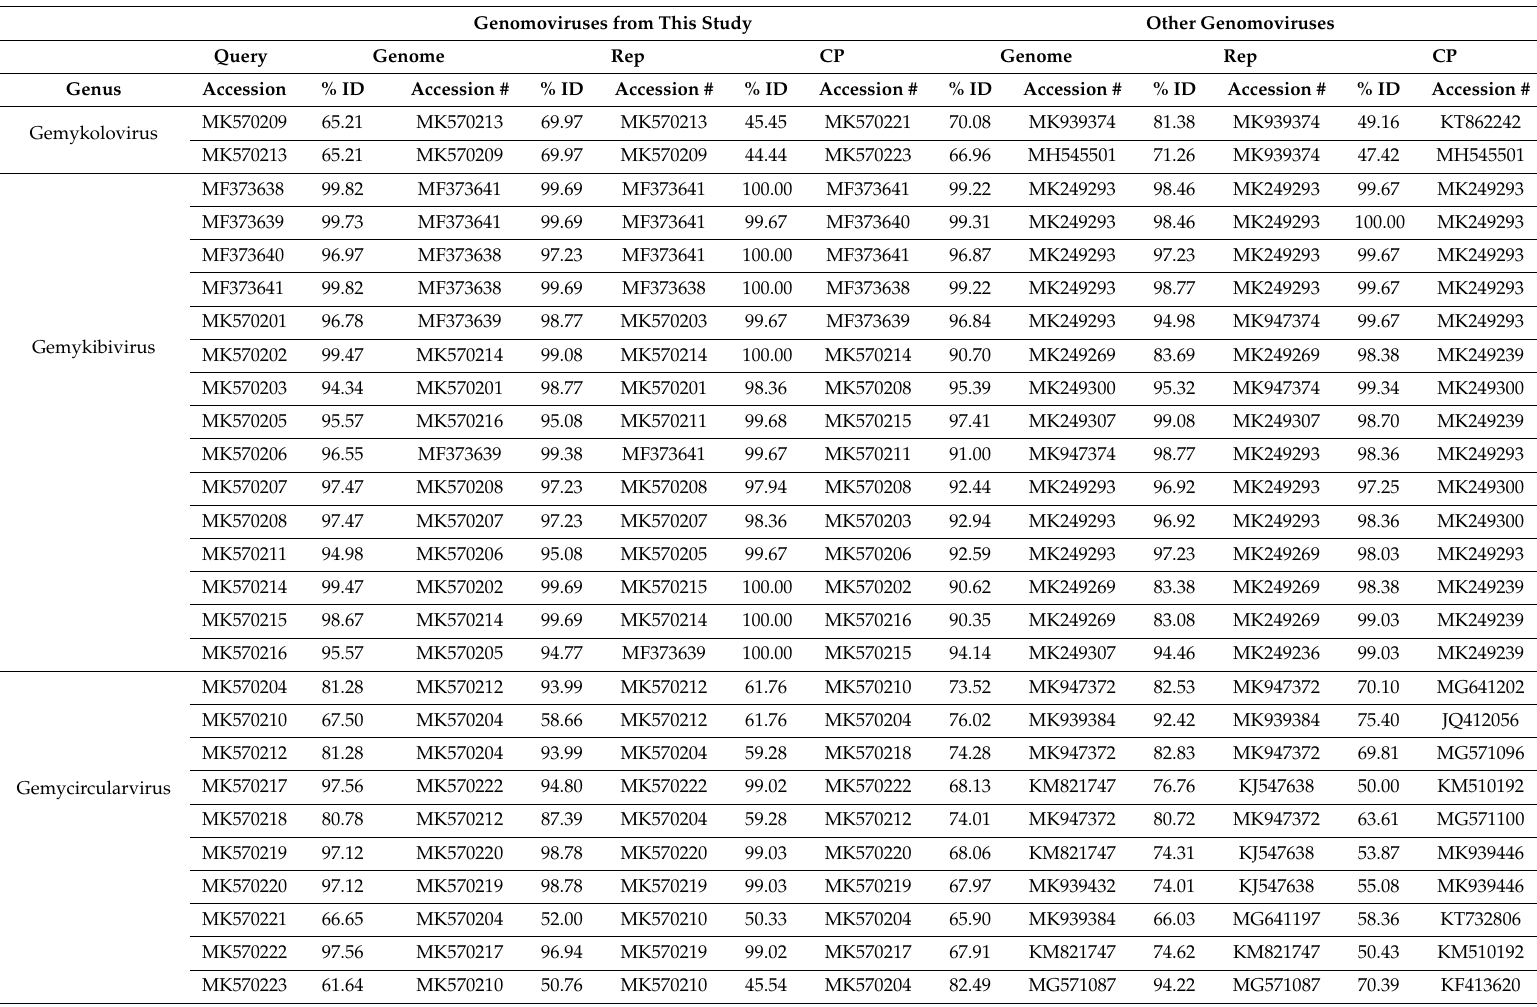
Table 2. Pairwise identity comparisons (showing highest identity) of the genome, and the replication associated protein (Rep) and capsid protein (CP) amino acid sequences of the genomoviruses identified in this study against themselves and those available in